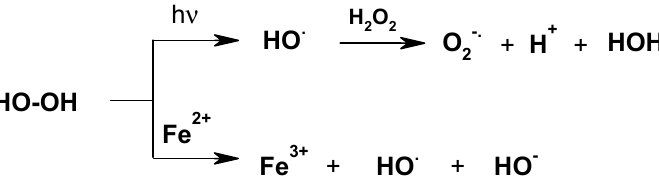
Figure 7. Activation of dihydrogen peroxide via the generation of radicals.